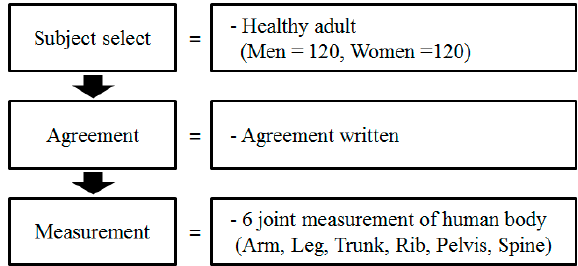
Figure 1. Experimental procedure.